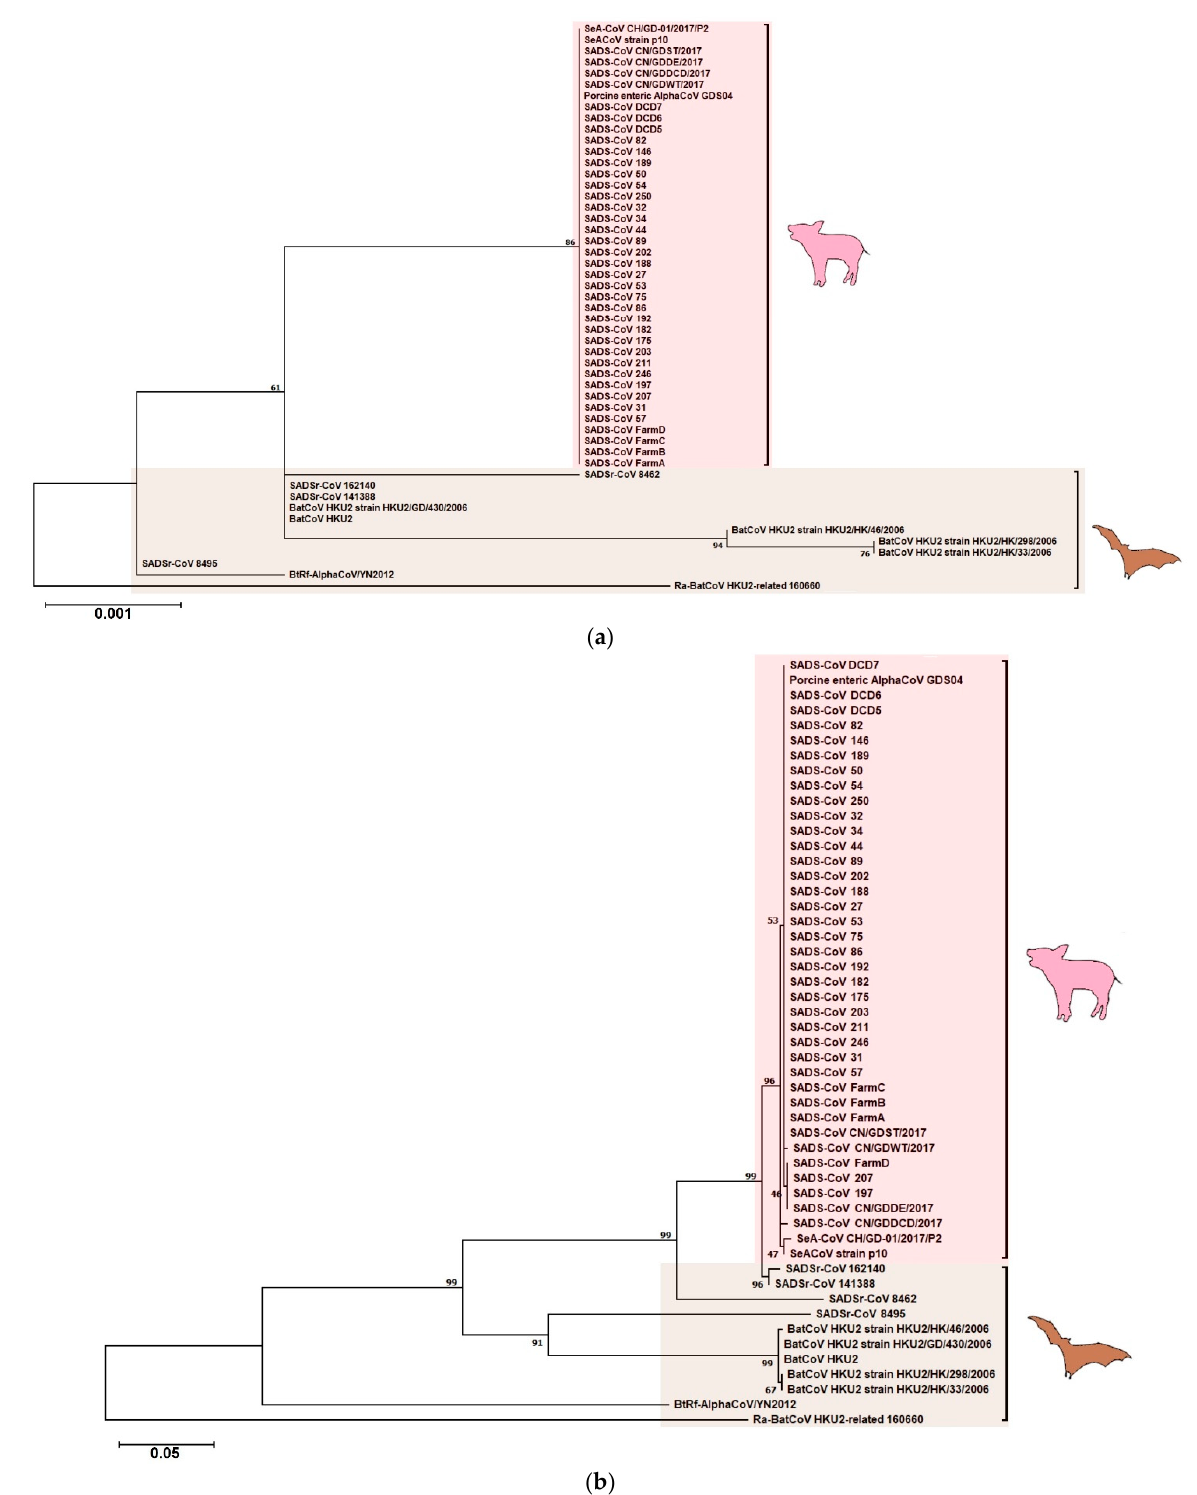
Figure 6. Maximum-likelihood phylogeny based on the amino acid sequences of selected BatCoV HKU2 and swine-related BatCoV HKU2 ( a ) nsp12 and ( b ) S1 domains. ( a ) a Jones–Taylor–Thornton (JTT) model of amino acid substitution and ( b ) a Whelan–Goldman matrix (WAG) model with a discrete gamma ( γ ) distribution of amino acid substitution was used in the respective analyses. 1000 trees were set for bootstrap values calculation. All bootstrap values and the scale bars indicating the number of amino acid substitutions per site are shown. Viral strains highlighted in pink color represents Table 2 cluster; brown color represents the BatCoV HKU2